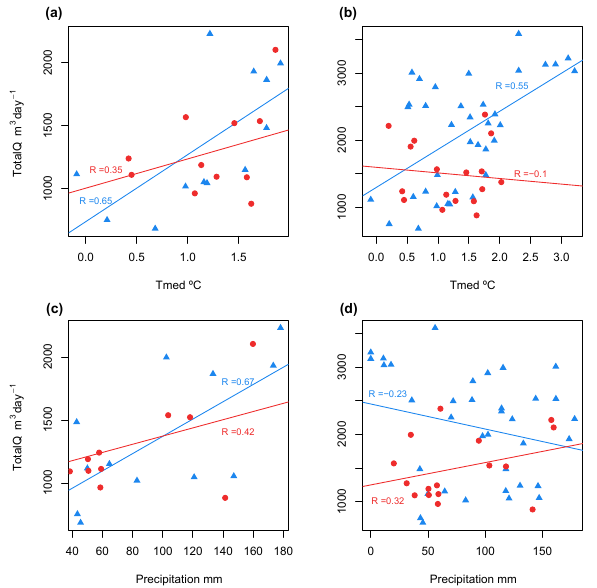
Figure 8. Correlations between monthly flow and monthly temper- ature (a, b) and precipitation (c, d) for (a, c) 2013–2014 (blue trian- gles) and 2017 (red circles), which are considered as analogues in terms of amounts of flow, and (b, d) months before the May 2016 breakpoint (blue triangles) and months after May 2016 breakpoint (red